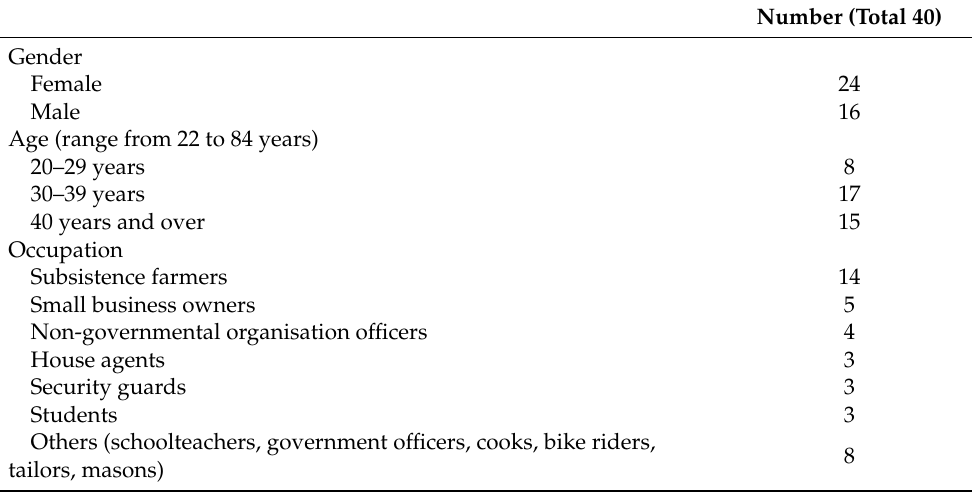
Table 1. Characteristics of research participants.